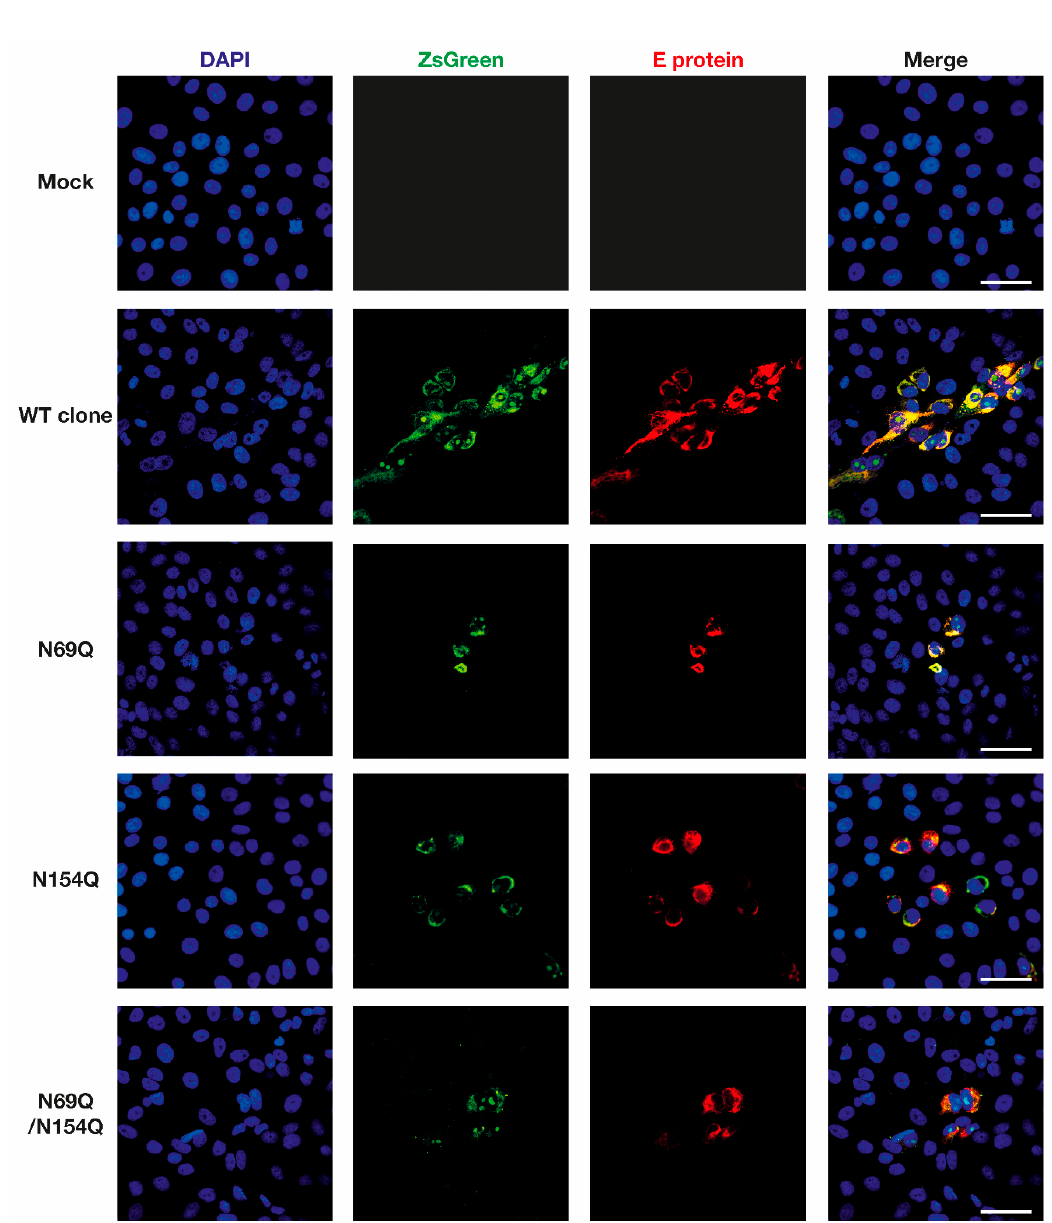
Figure 2. Confirmation of the inserted-marker (ZsGreen) and ZIKV E protein expression from rescued ZIKV variants. Vero B4 cells were grown on eight-well chamber slides. At 50% confluence, the cells were transfected with in vitro transcribed ZIKV RNA. At 72 hpt, the cells were fixed and stained with rabbit anti-ZIKV E antibody, anti-rabbit conjugated to Alexa Fluor 568 and DAPI. The samples were analyzed using a Nikon A1R+ confocal microscope and ImageJ software. Scale bar = 50 µm. DAPI = 4 ′ ,6-diamidino-2-phenylindole; ZsGreen = green fluorescent protein derived from Zoanthus sp. ; E protein = envelope protein; WT clone = wild-type ZIKV with the ZsGreen reporter gene; N69Q = ZIKV with a mutated N-glycosylation site in prM; N154Q = ZIKV with a mutated N-glycosylation site in E; N69Q/N154Q = ZIKV with mutated N-glycosylation sites in prM and E.